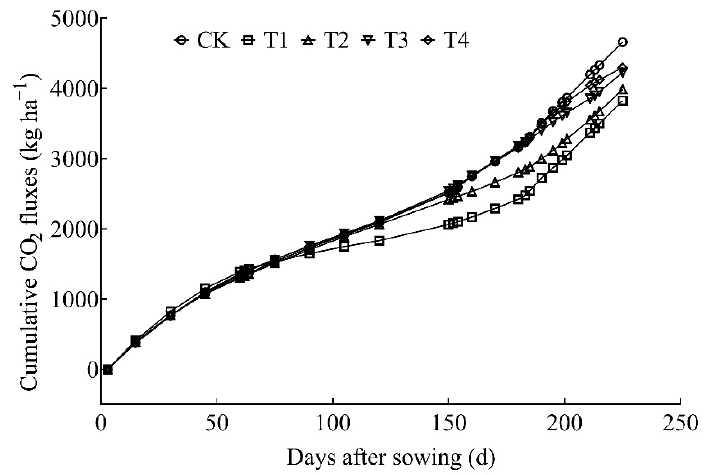
Figure 3. Cumulative soil CO 2 emissions (kg ha − 1 ) under different irrigation treatments during a winter wheat growing season. winter wheat growing season.